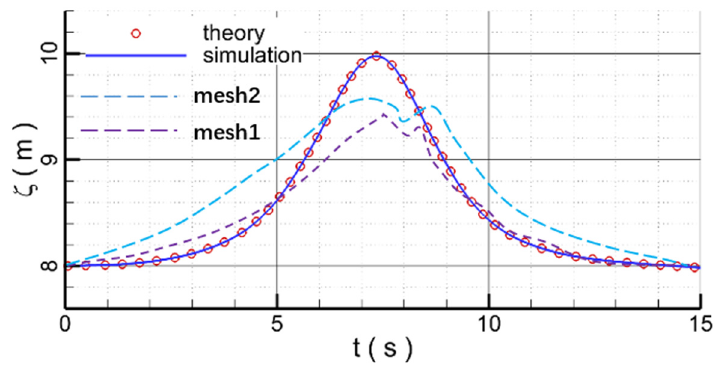
Figure 1. Solitary wave comparison between the theory values and the simulation results.